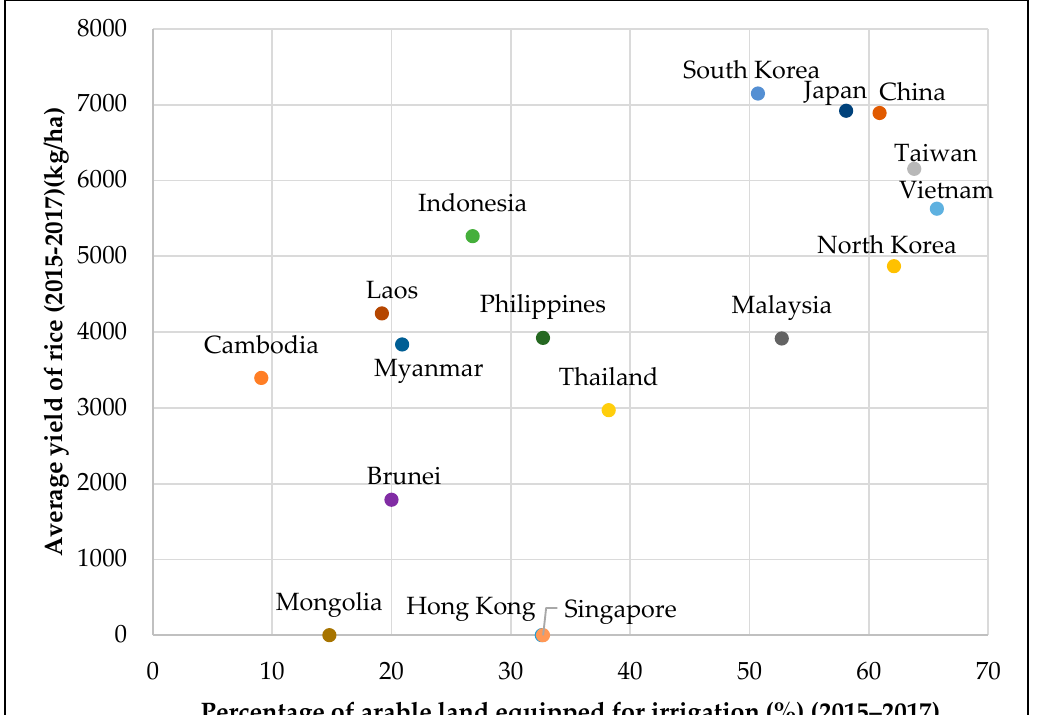
Figure 6. Relationship between the percentage of arable land equipped for irrigation and average yield of rice (2015–2017) in East and Southeast Asian economies (Source: based on data from [4]).